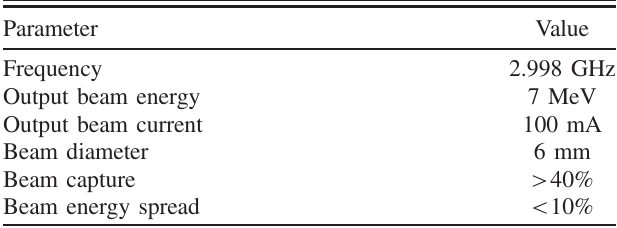
TABLE IV. Output electron beam parameters.